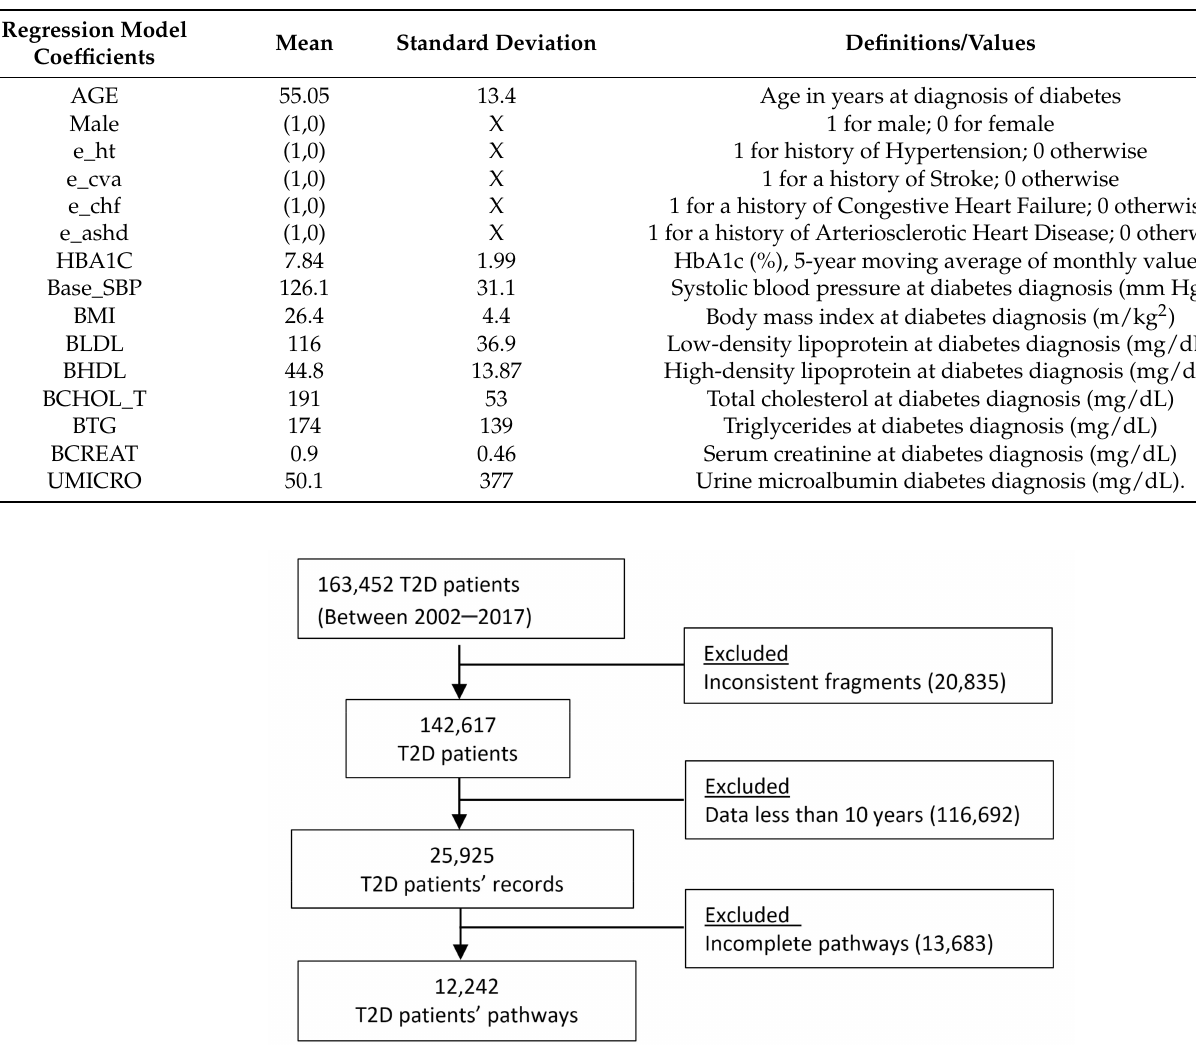
Table 2. General characteristics of T2D patients in NHIRD of Taiwan.